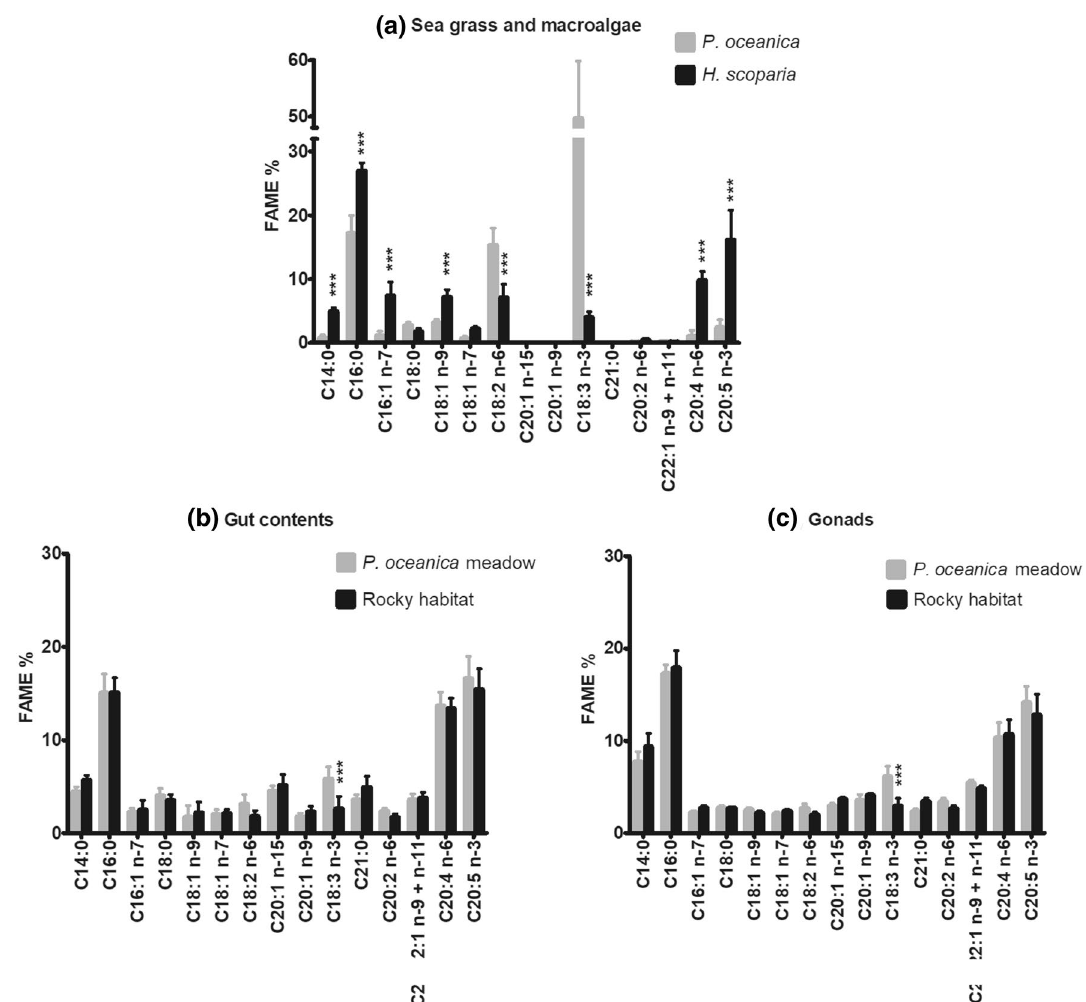
Figure 3. Fatty acid profiles (annual mean values, % with SD) of P. oceanica and H. scoparia ( a ), P. lividus gut contents ( b ) and gonads ( c ) from P. oceanica meadow and rocky bottom. Associated asterisks *, **, *** indicate significant differences between the two areas for each fatty acid, with P < 0.05, P < 0.01 and P < 0.001,